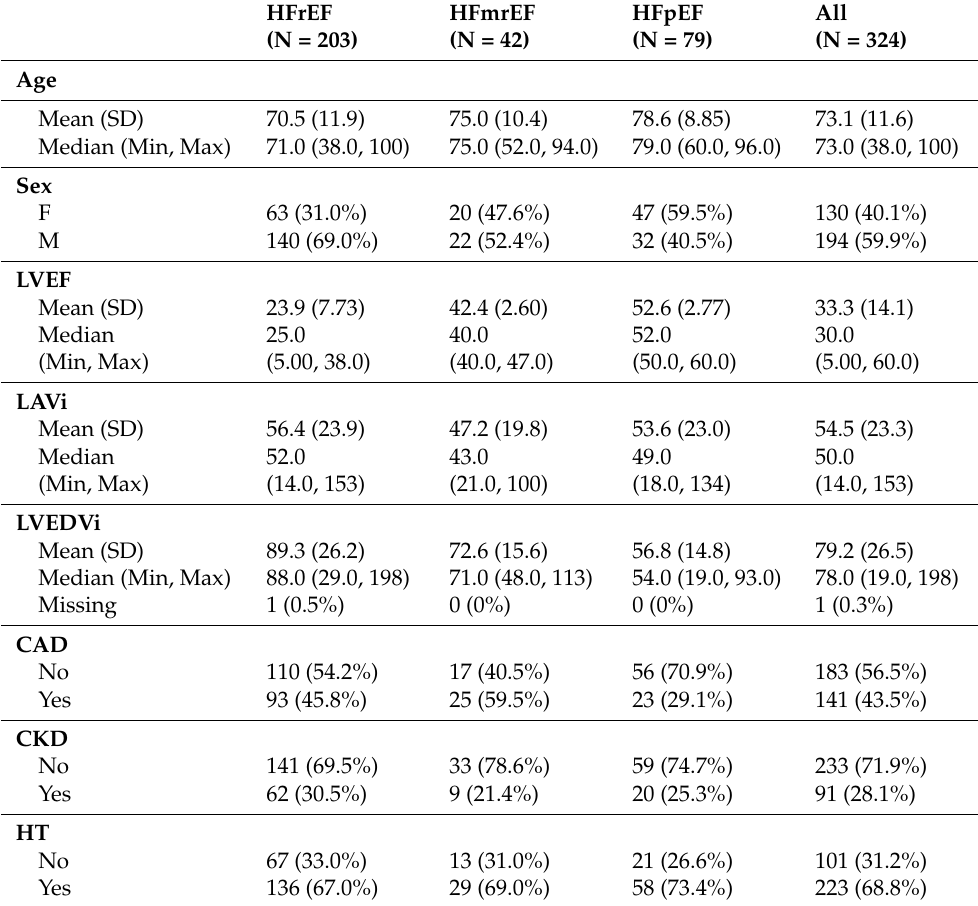
Table 1. Baseline characteristics of patients with HF and AF, according to